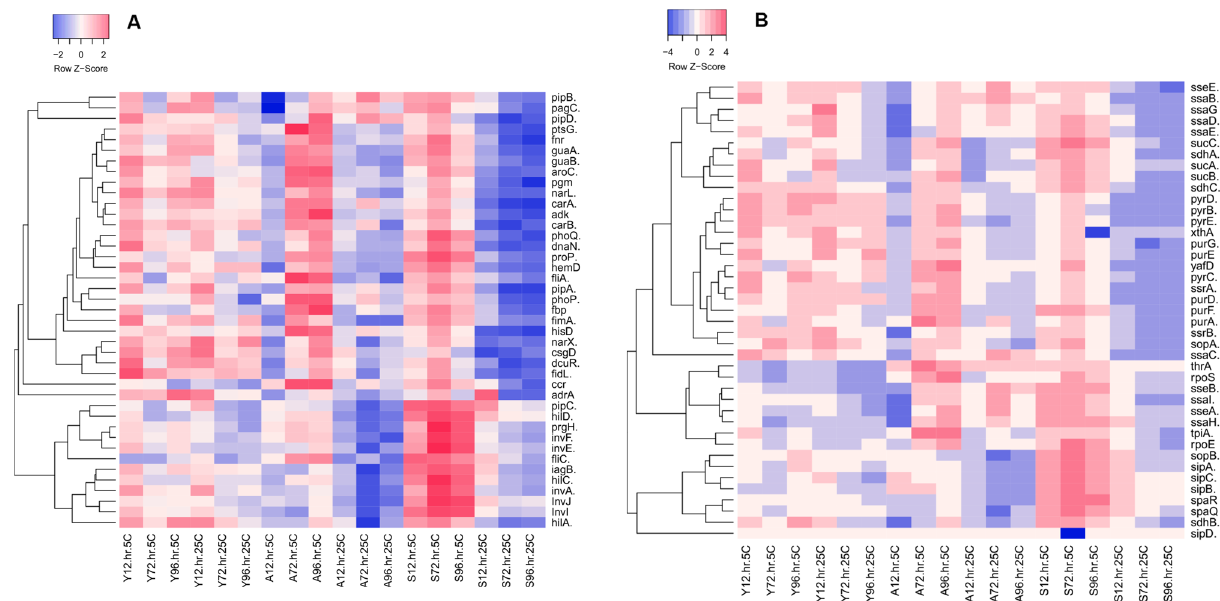
Figure 6. Mean relative expression of genes regulated at two different temperatures (5 °C and 25 °C) and at different storage time-points (12, 72 and 96 h) in various egg components (Y for yolk; A for albumen and S for shell wash). The log 2 fold change expression values were visualized in Heatmapper web software by using the average linkage clustering method and Spearman rank correlation. Panels ( A ) and ( B ) show the list of 82 genes divided into two groups for the ease of